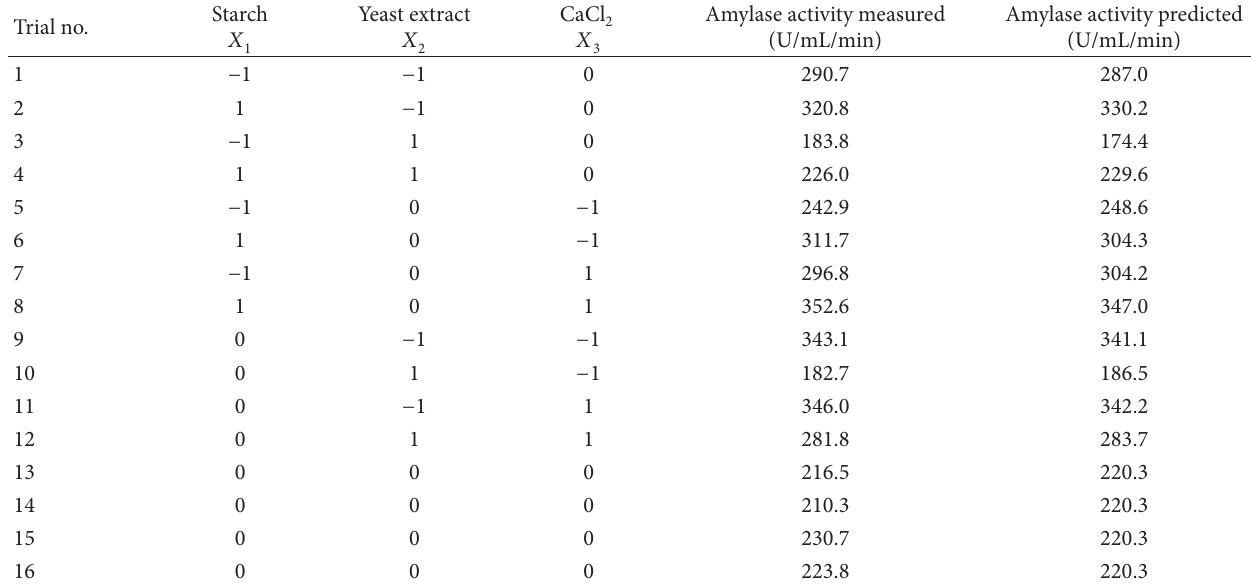
-amylase enzyme activity as in�uenced by 𝛼𝛼